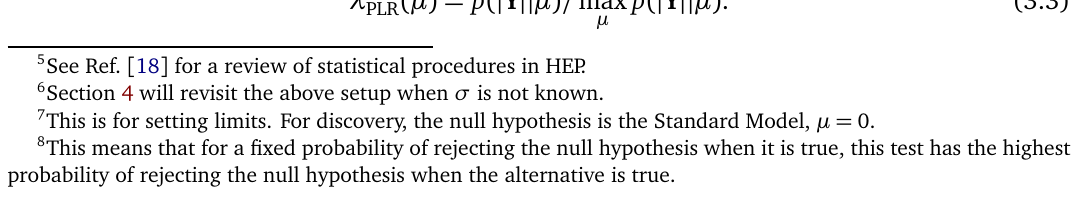
Figure 2: A histogram of Y a δ -function and resolution effects are independent for both ‘decay products’, the measured distribution of Y and background. A constant value of σ is used for all